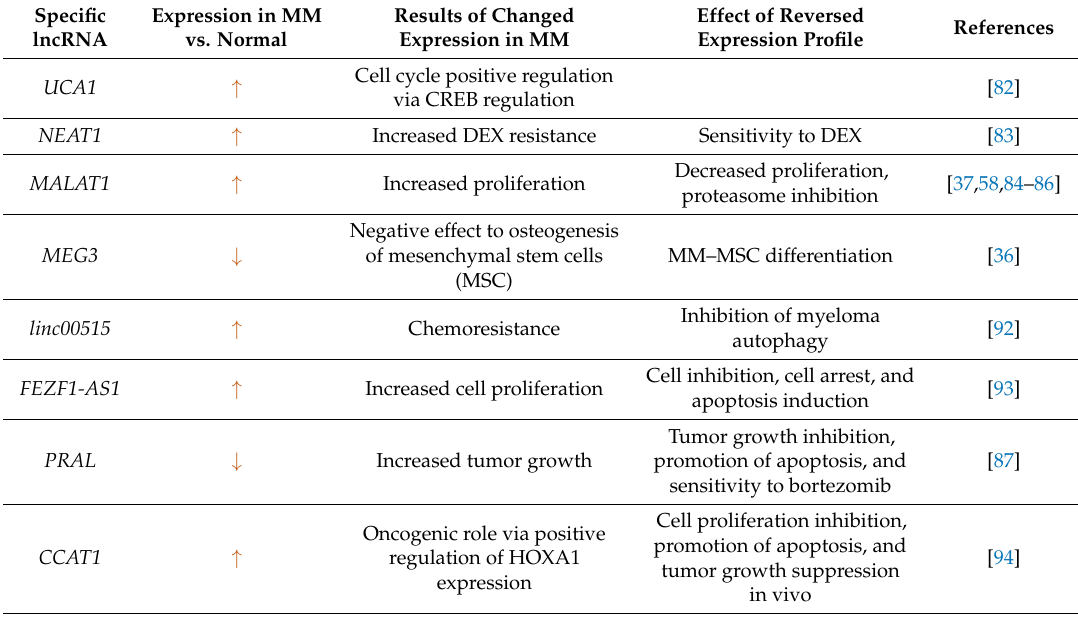
Table 1. Specific long non-coding RNAs found in multiple myeloma